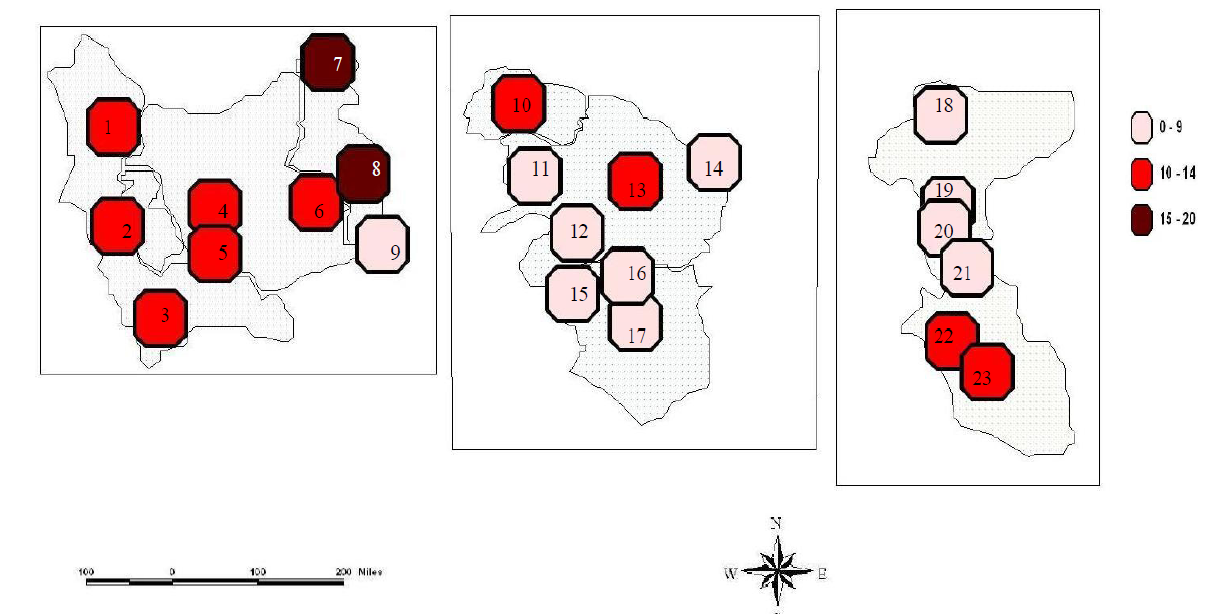
Fig. 3. Location rating based on precipitation. 1-Kooy; 2-Oroomieh; 3-Mahabad; 4-Tabriz; 5-Maragheh; 6-Sarab; 7-Parsabad; 8-Ardebil; 9-Khalkhal; 10-Bojnurd; 11-Sabzevar; 12-Kashmar; 13-Mashhad; 14-Sarakhs; 15-Ghaen; 16-Ferdous; 17-Birjand; 18-Kashan; 19-Isfahan; 20-Shargh Isfahan; 21-Abadeh; 22-Shiraz; 23-Fassa